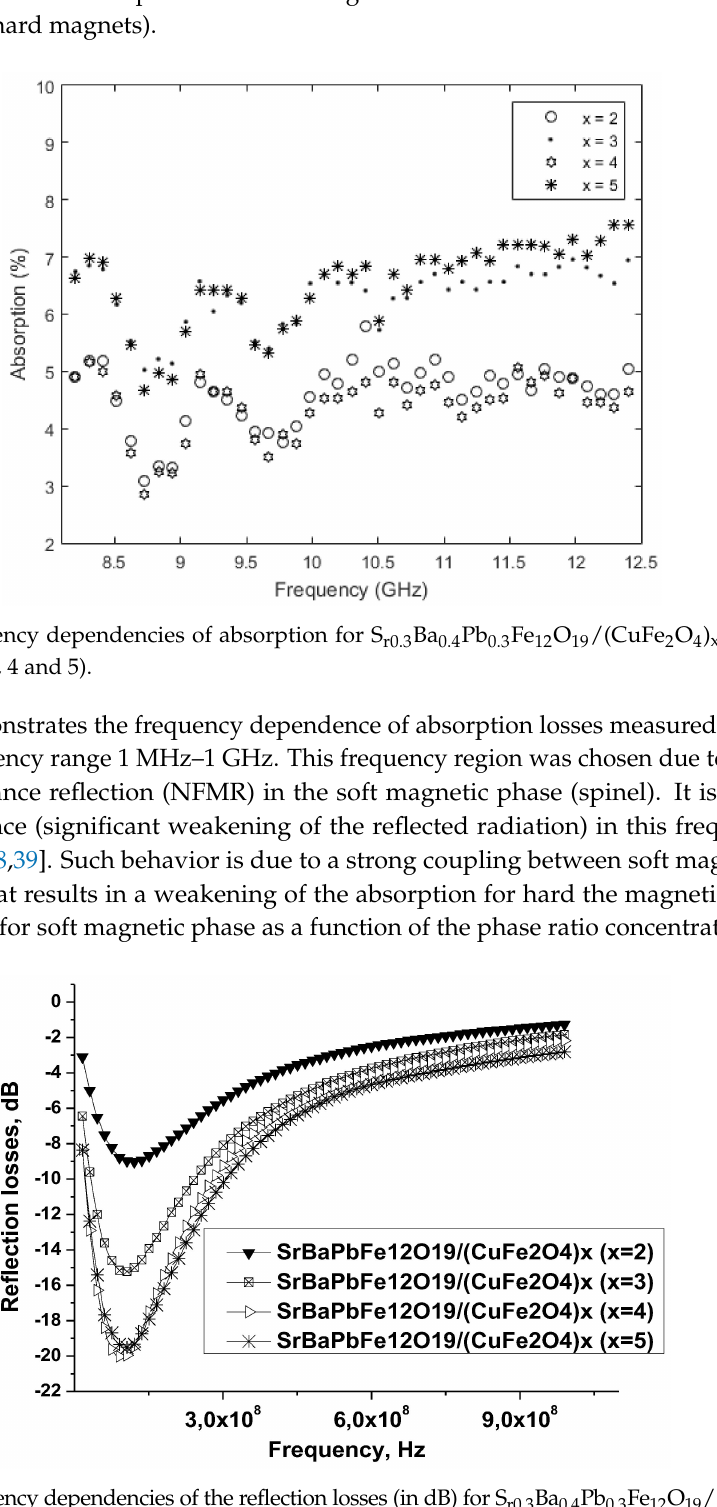
Figure 10. Frequency dependencies of the reflection losses (in dB) for S r0.3 Ba 0.4 Pb 0.3 Fe 12 O 19 / (CuFe 2 O 4 ) x composite samples (x = 2, 3, 4 and